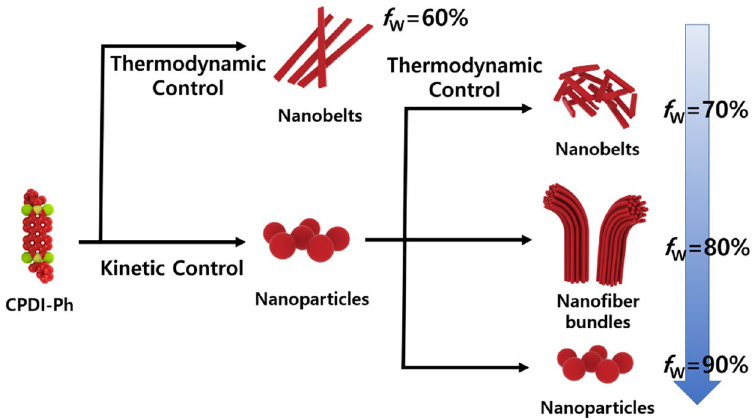
Figure 4. Schematic representation of the morphological transformation of